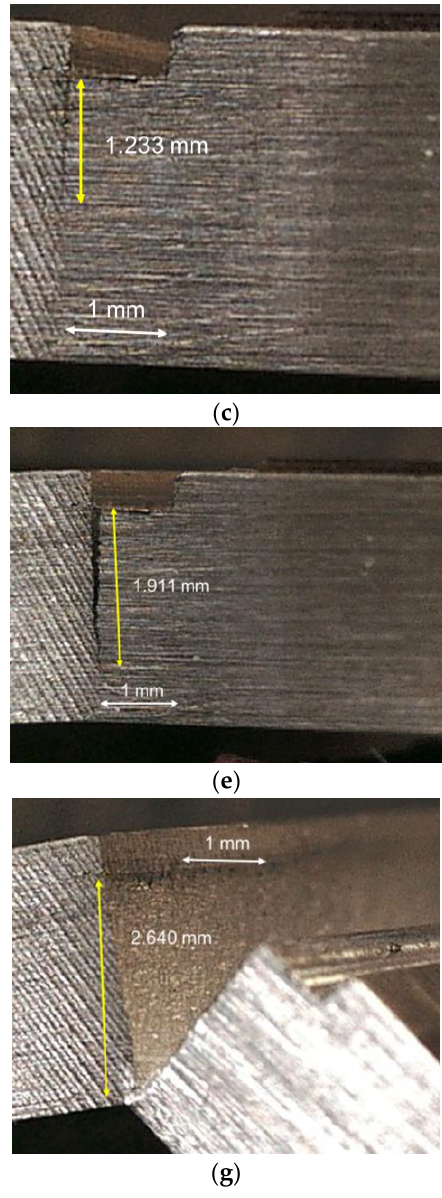
Figure 30. Sequence of crack propagation of pre-seeded 0.5 mm crack depth at room temperature. ( a ) 1st capture at crack initiation, ( b ) 2nd capture, ( c ) 3rd capture, ( d ) 4th capture, ( e ) 5th capture, ( f ) 6th capture, ( g ) 7th capture.